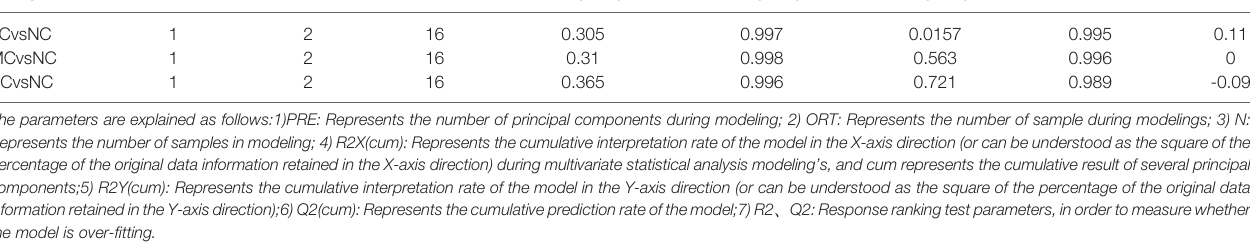
TABLE 1 | OPLS Models and corresponding parameters of the 3 groups. Group